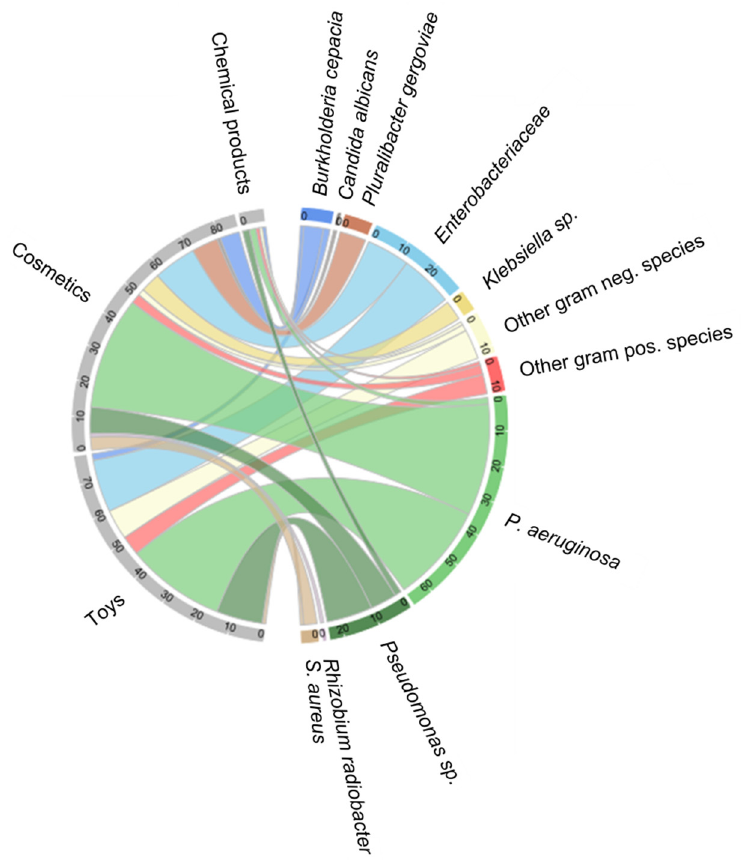
Figure 2. Microorganisms identified in the product categories toys, cosmetics, and chemicals. The arc lengths on the outer circle are proportional to the fractions of the product categories and number of microorganisms.